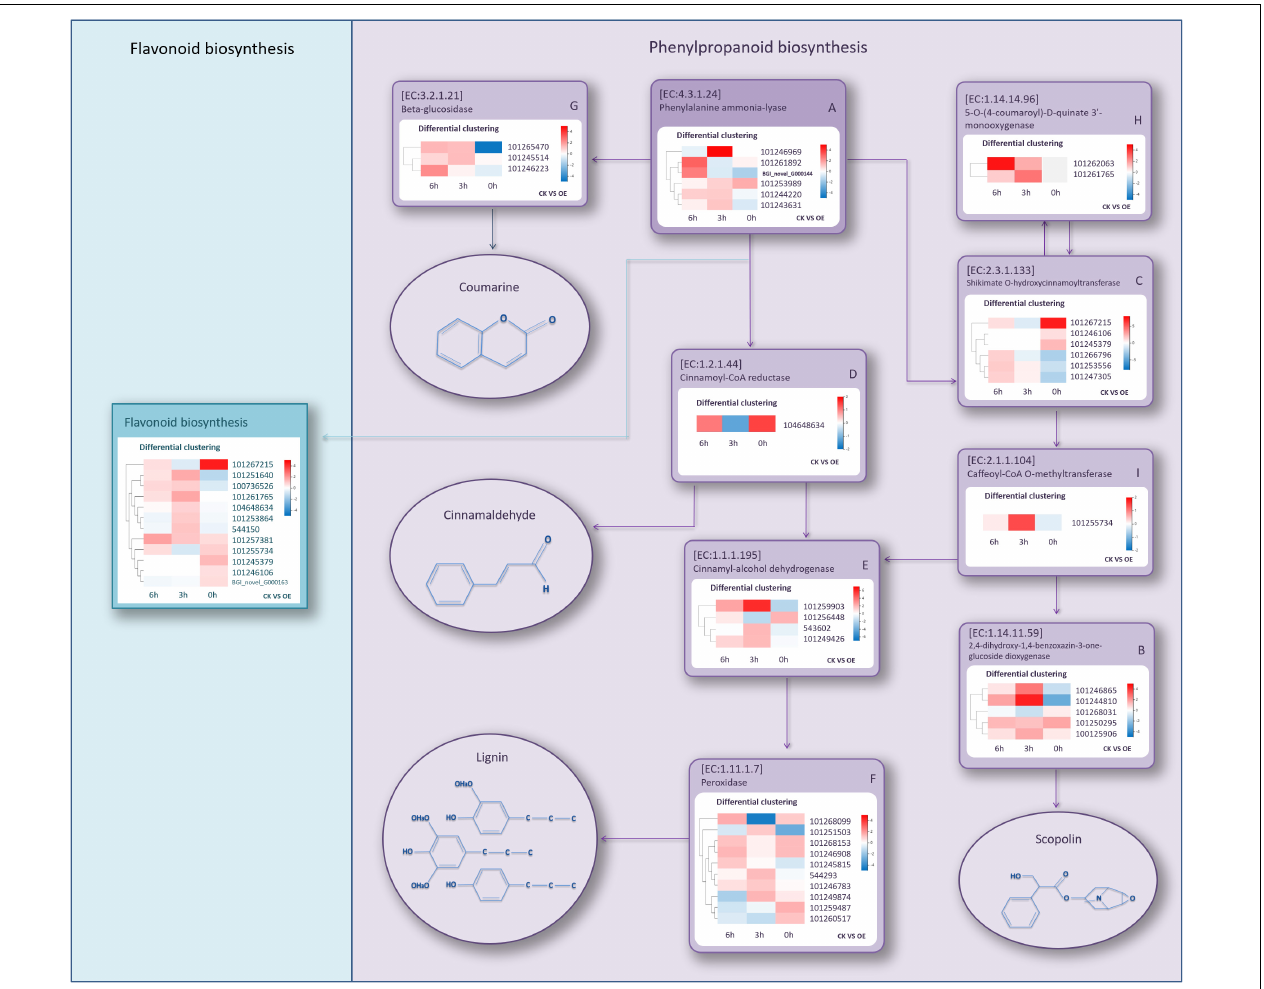
FIGURE 8 | Simplified schematic diagram of regulatory points with upregulated genes encoding various enzymes and heatmaps of differential expression of these genes. The compounds in the circles are the metabolites catalyzed by these